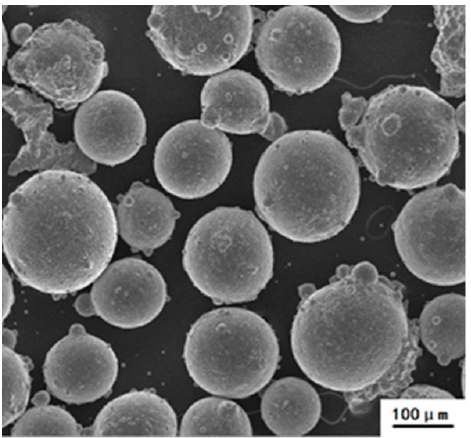
Table 1. Chemical composition of as-received stainless steel powders.